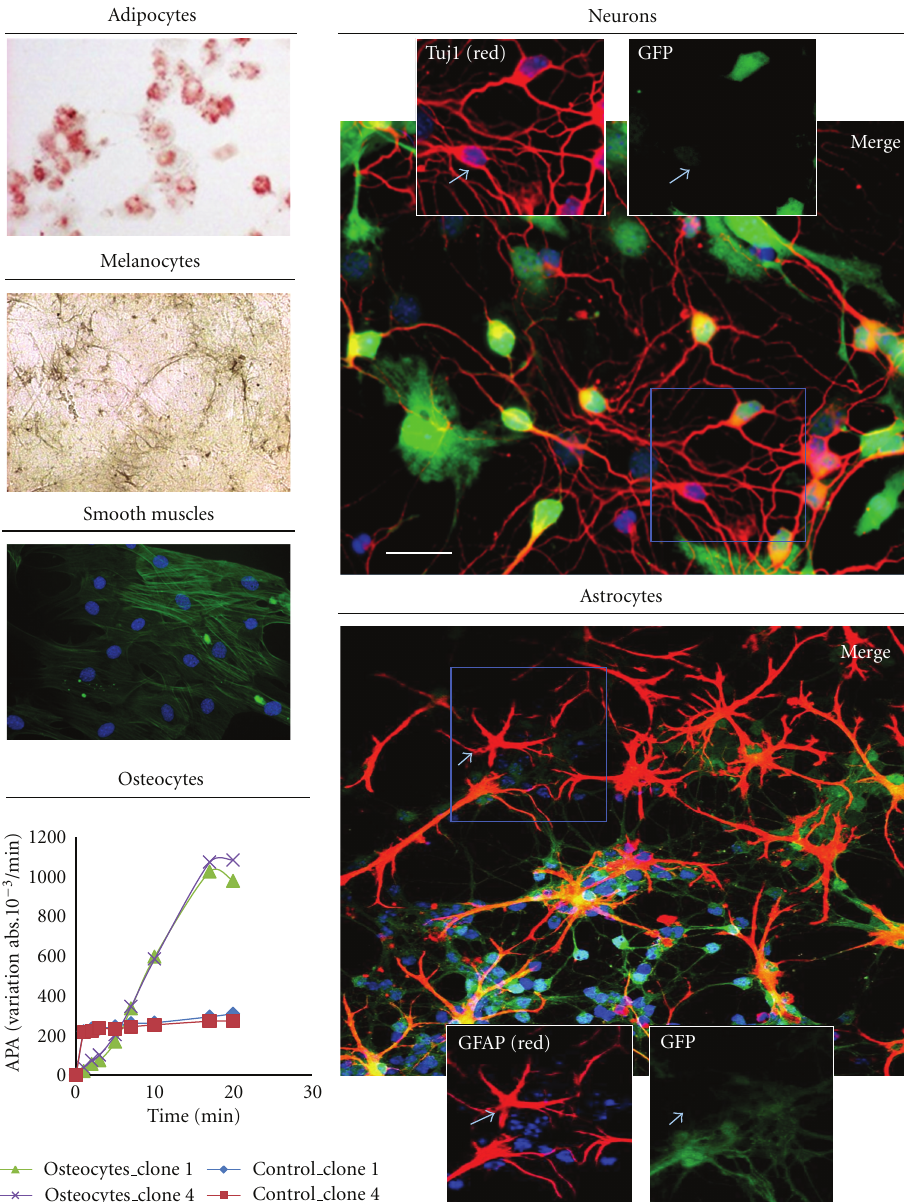
Figure 4: Multipotency of adult bone marrow NCSC. NCSC clones were subjected to di ff erentiating protocols and were shown to be able to di ff erentiate into adipocytes (Oil Red O labeling), melanocytes (L-DOPA labeling), smooth muscles (SMA-labeling), and osteocytes (alkaline phosphatase activity). Moreover, when co-cultured with cerebellar granule neurons, we were able to di ff erentiate NCSC clones into neurons (beta-III tubulin labeling by Tuj1 monoclonal antibody) or glial cells (GFAP